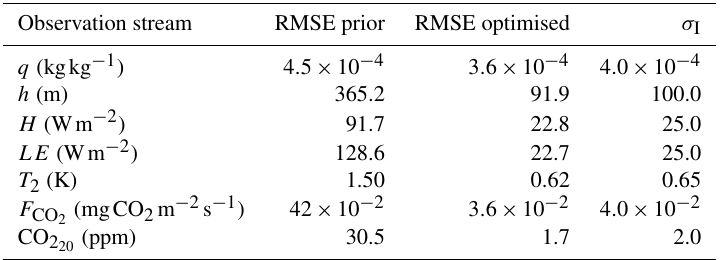
Table 3. The root mean squared error (RMSE) and the specified measurement error standard deviation ( σ I ) for the observation streams in the 10-parameter-state OSSE with perturbed observations. In all our OSSEs, the measurement error standard deviations are chosen to be constant with time. Note that the measurement error equals the observational error here, since the model and representation errors were set to 0 for simplicity. The σ I are identical for all OSSEs in Table 2, but not all observation streams are used in each